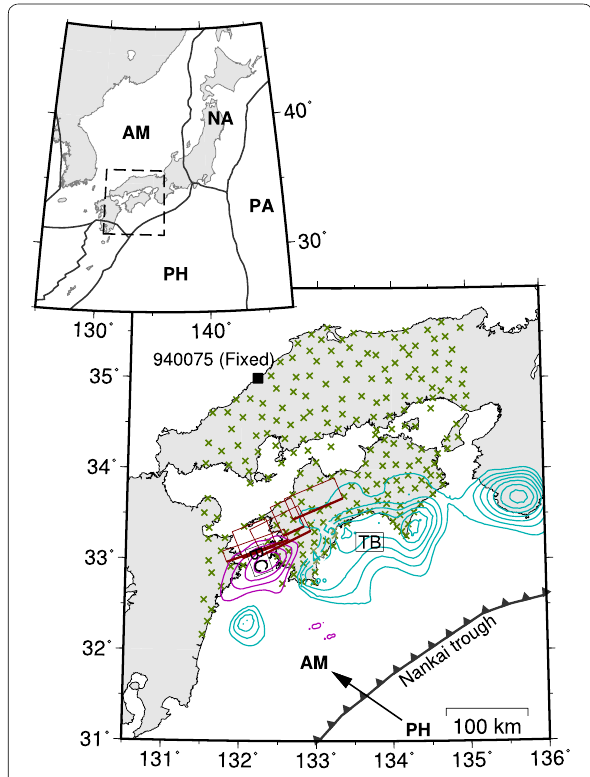
Fig. 1 Tectonic settings around the Shikoku region. Solid lines are the plate boundaries, as per the study by Bird (2003). AM, NA, PA, and PH denote the Amurian, North American, Pacific, and Philippine Sea plates, respectively. TB and BC denote the Tosa Bay and the Bungo Channel areas, respectively. Small crosses denote the GEONET stations that were used in this study, whereas the black square denotes GEONET 940075, which was used as a fixed point. Blue and red contours show the coupling and the long-term SSE in BC between 2010 and 2011, and dark red rectangles show fault models of the short-term SSE published by Sekine et al.